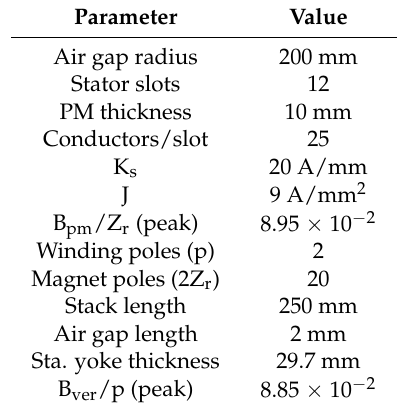
Table 1. Specifications of the designed PM vernier motor.